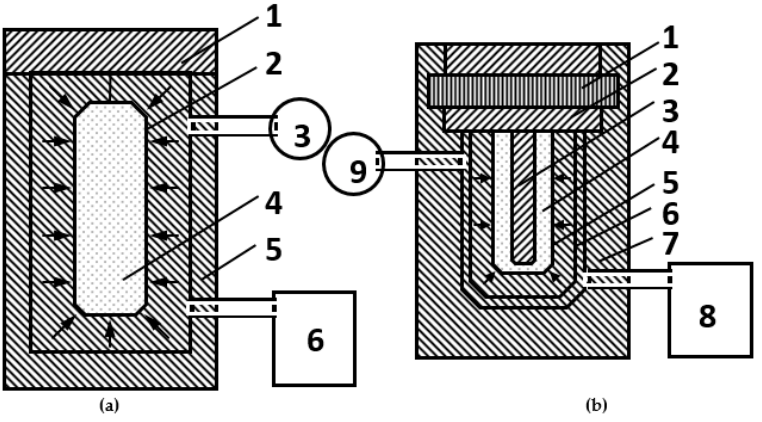
Figure 2. Schemes of CIP presses: ( a ) wet-bag 1—lid, 2—elastomeric mold, 3—pressure gauge, 4—powder, 5—high-pressure chamber, 6—compressor; ( b ) dry-bag 1—bayonet shutter; 2—cutter; 3—cavity-forming core, 4—powder, 5—elastomeric mold, 6—perforated limiter conforming to the green body shape, 7—container, 8—compressor, 9—high-pressure chamber.